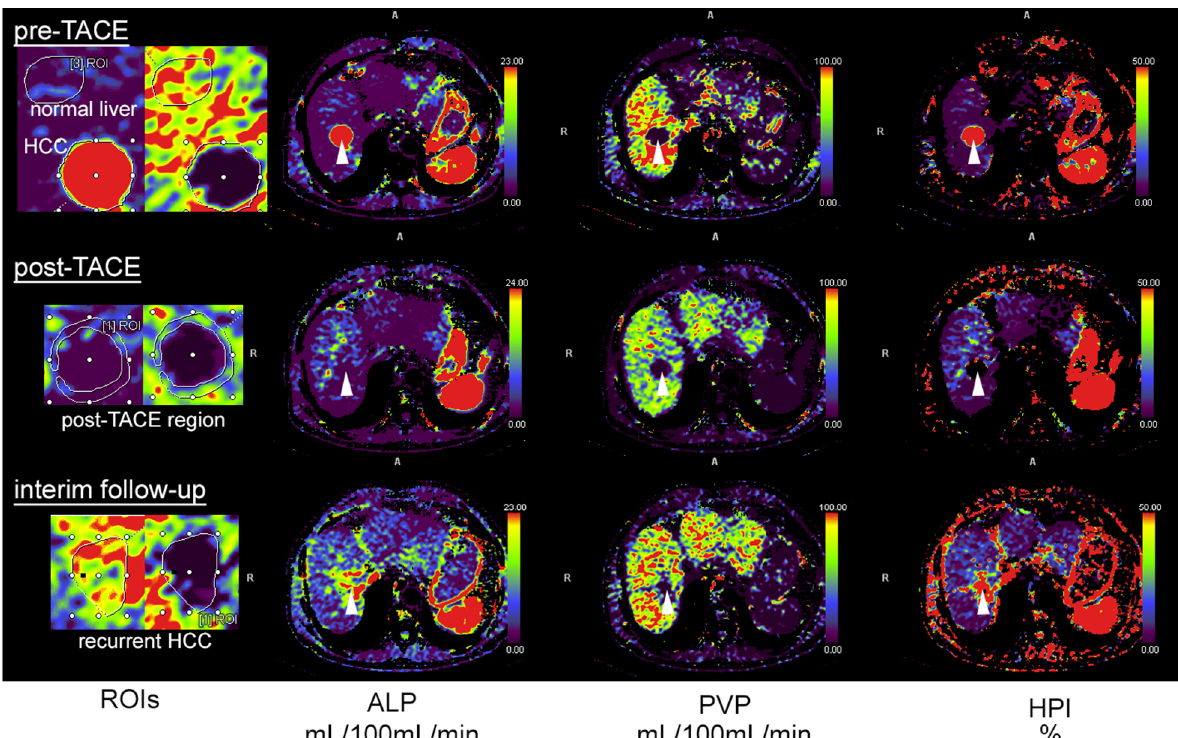
Figure 1. A 78-year-old patient with HCC and transarterial chemoembolization (TACE). Pre-TACE images (top row) show increased arterial-liver perfusion (ALP, second column, white arrowhead), reduced portal-venous perfusion (PVP, third column) and increased hepatic-perfusion index (HPI, right) compared to normal liver tissue. Post-TACE images (middle row) demonstrate a complete loss of lesion ALP, PVP and HPI, indicative of complete embolization. The follow-up after three months shows recurrent ALP at the site of embolization, highly suggestive of local recurrence.